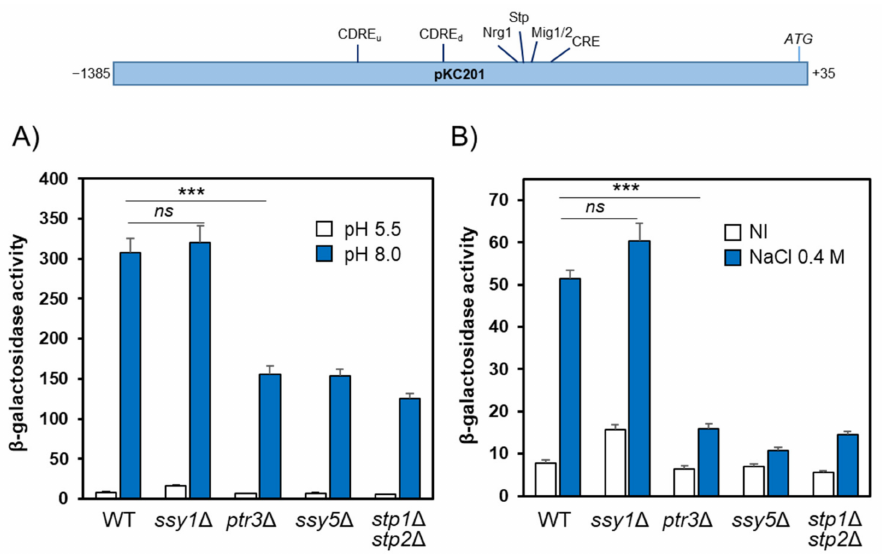
Figure 6. Effect of mutations in the SPS pathway on the expression of the full ENA1 promoter. Plasmid pKC201, bearing the entire ENA1 promoter fused to lacZ , was introduced into strain 23344c (WT) and its isogenic ptr3 , ssy5 , ssy1 , and stp1 stp2 derivatives. Cells were exposed for 1 h to alkaline pH ( A ) or 0.4 M NaCl ( B ) and processed for β -galactosidase activity determination. “NI” denotes not induced. Data are mean ± SEM from 4 to 10 independent experiments. ***, p < 0.005, ns , not significant. The gene structure and relevant regulatory sites in the ENA1 promoter included in plasmid pKC201 are indicated in the cartoon shown at the top. CDREu and CDREd refer to the upstream and downstream elements,